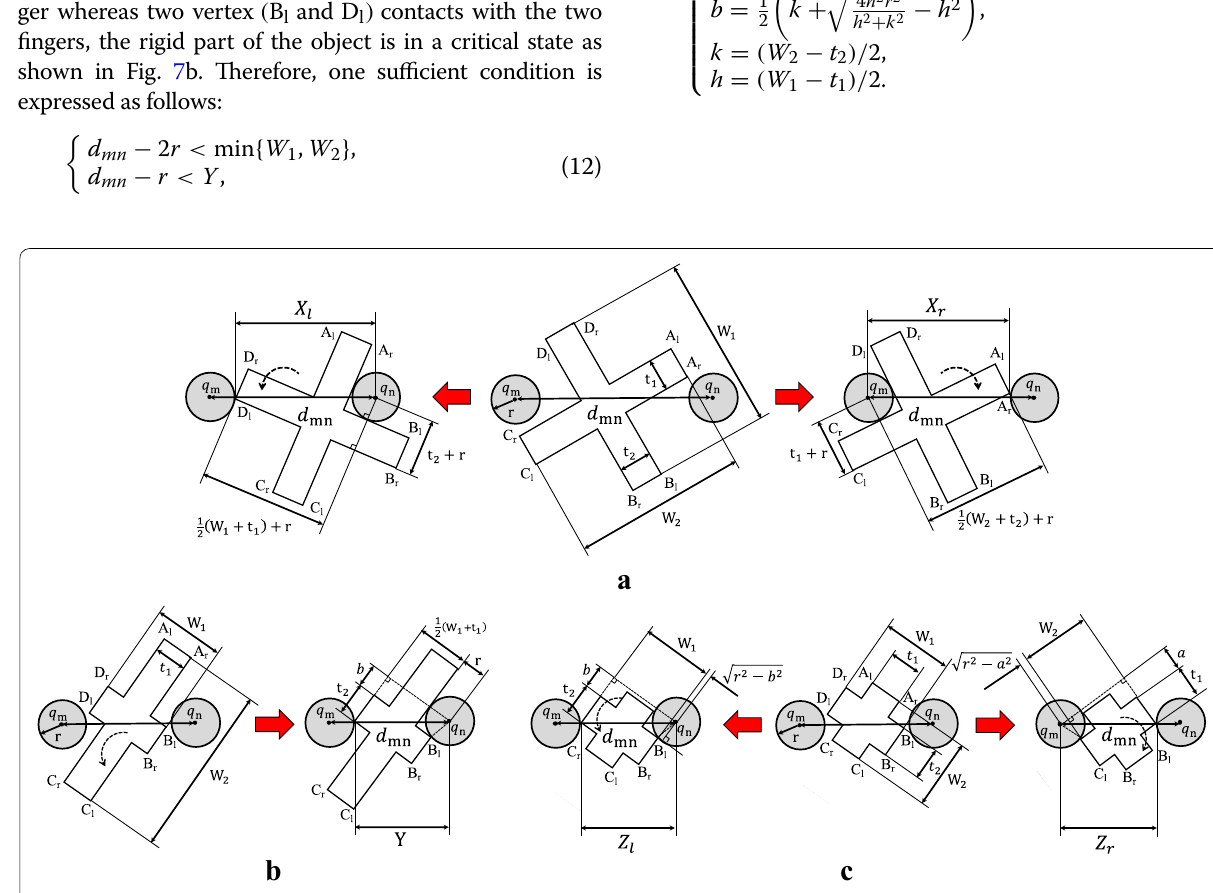
Fig. 7 Rigid-part caging condition. a (i), b (ii), and c